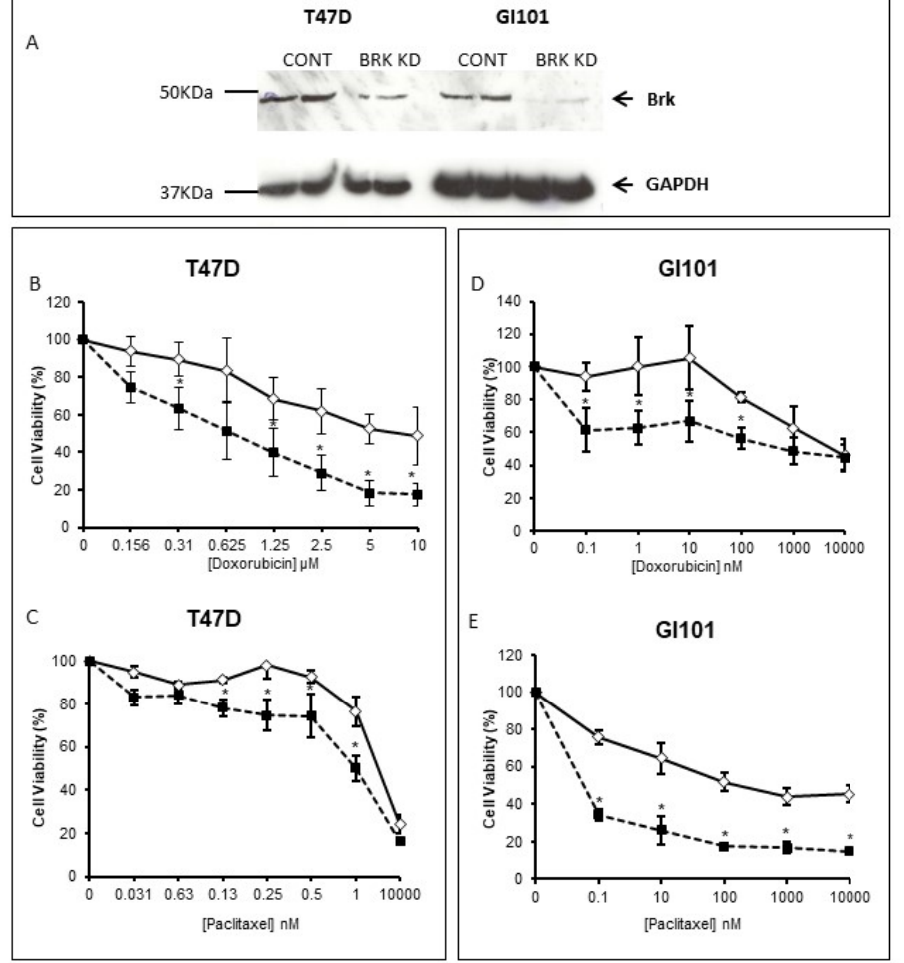
Figure 2. Brk moderates cell responses to chemotherapeutic agents. Brk levels were suppressed in T47D and GI101 cells by RNAi (Brk KD) and suppression was confirmed by Western blotting ( A ); the cells were seeded and allowed to adhere overnight in 96-well plates. Cells were treated with either doxorubicin ( B , D ) or Paclitaxel ( C , E ) for 72 h. Cell viability was determined by MTT assay and expressed as a percentage of the control (vehicle only) wells. The mean % survival (+/ − SD) of a representative experiment is plotted with the control (transfected with no-target siRNA) in open diamonds and Brk-suppressed cells in closed squares; * indicates p < 0.05.